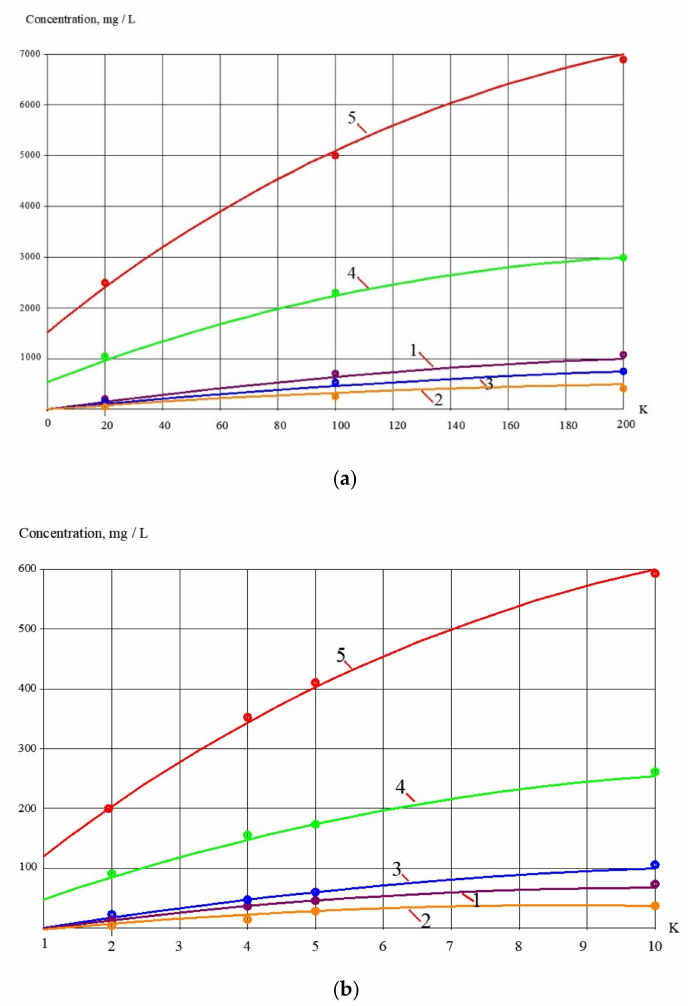
Figure 7. Dependences of calcium, chloride, sulphate and bicarbonate ions, as well as TDS values on K in the nanofiltration membrane permeate at the first step ( a ) and on the second step ( b ) of the first series of natural feed water concentrating: 1—chloride; 2—sulphates; 3—calcium; 4—bicarbonates;